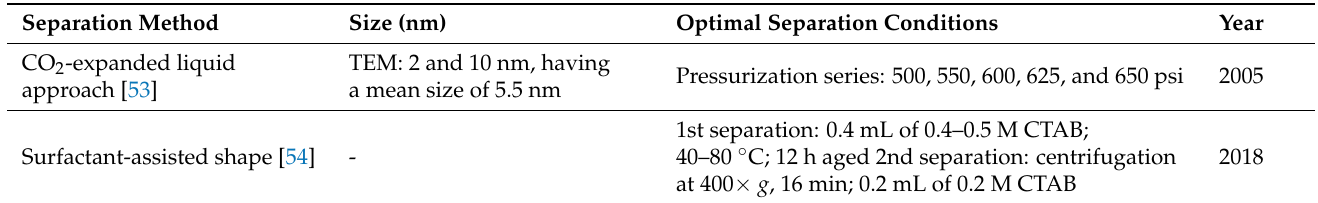
Table 6. Overview of the AgNPs separation by selective